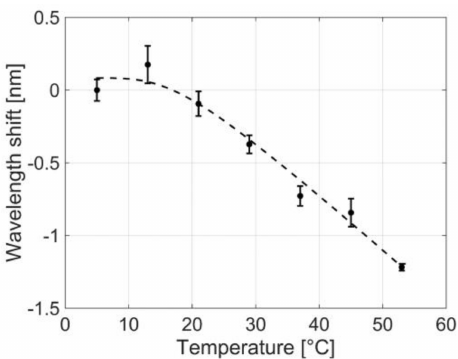
Figure A1. Resonant wavelength shift of the bare sample (without MGs) as function of water temperature. The dashed line was obtained with a smoothing spline fitting.